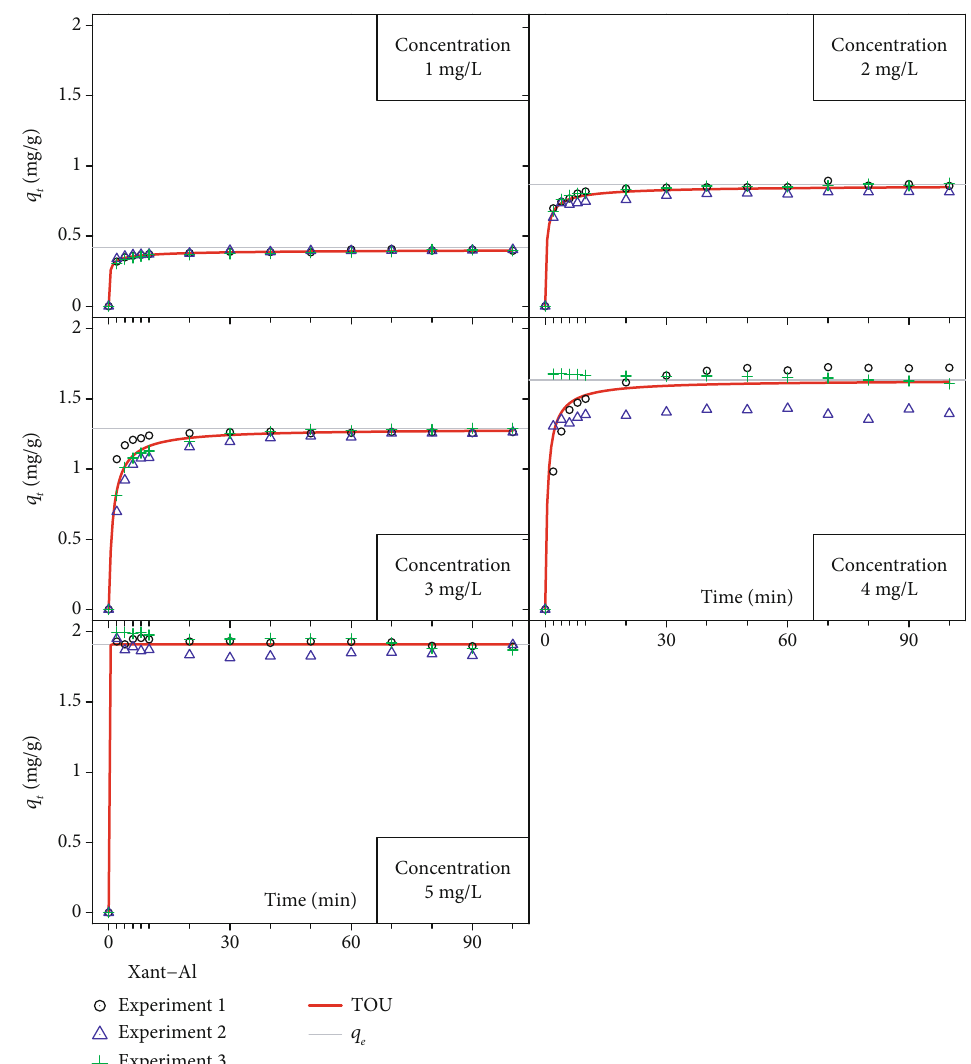
Figure 7: Kinetics of fl uoride adsorption by Xant-Al for fi ve initial fl uoride concentrations and the theoretical curve obtained from the TOU